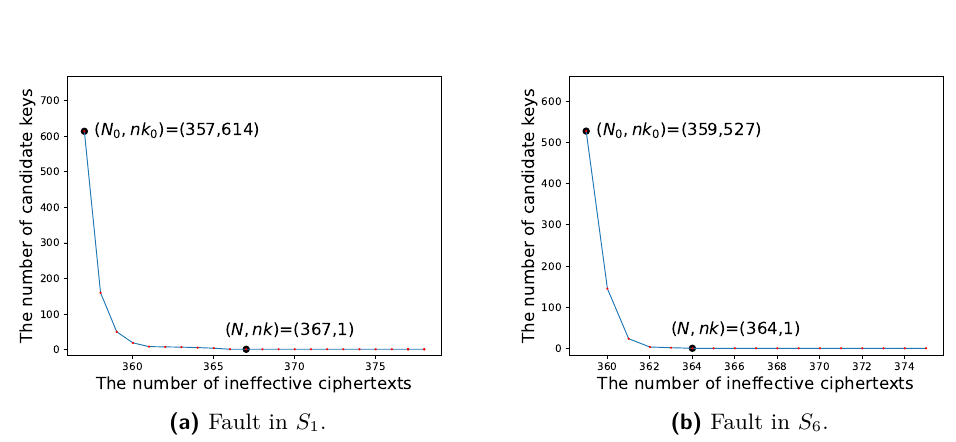
Figure 3: The simulation of Algorithm 2. The simulation is performed independently when the fault is injected in S